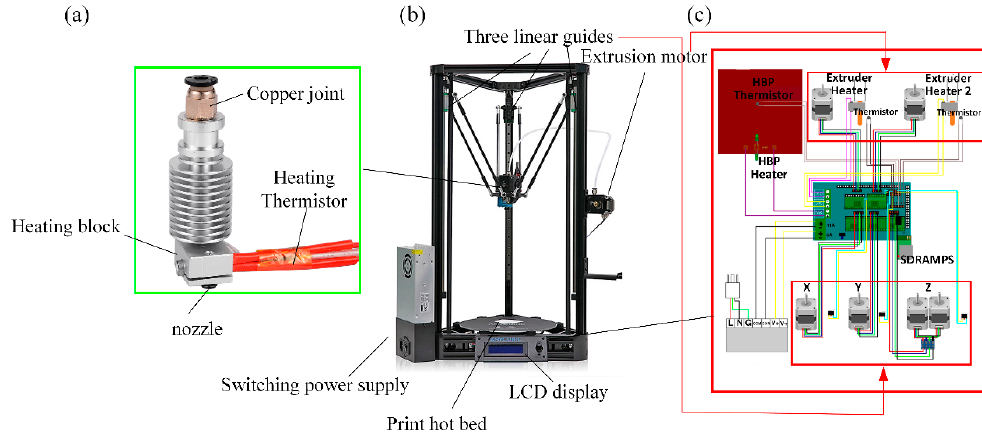
Figure 2. Kossel 3D Printer. ( a ) 3D printer head; ( b ) 3D printer overall structure; ( c ) Printer control board.